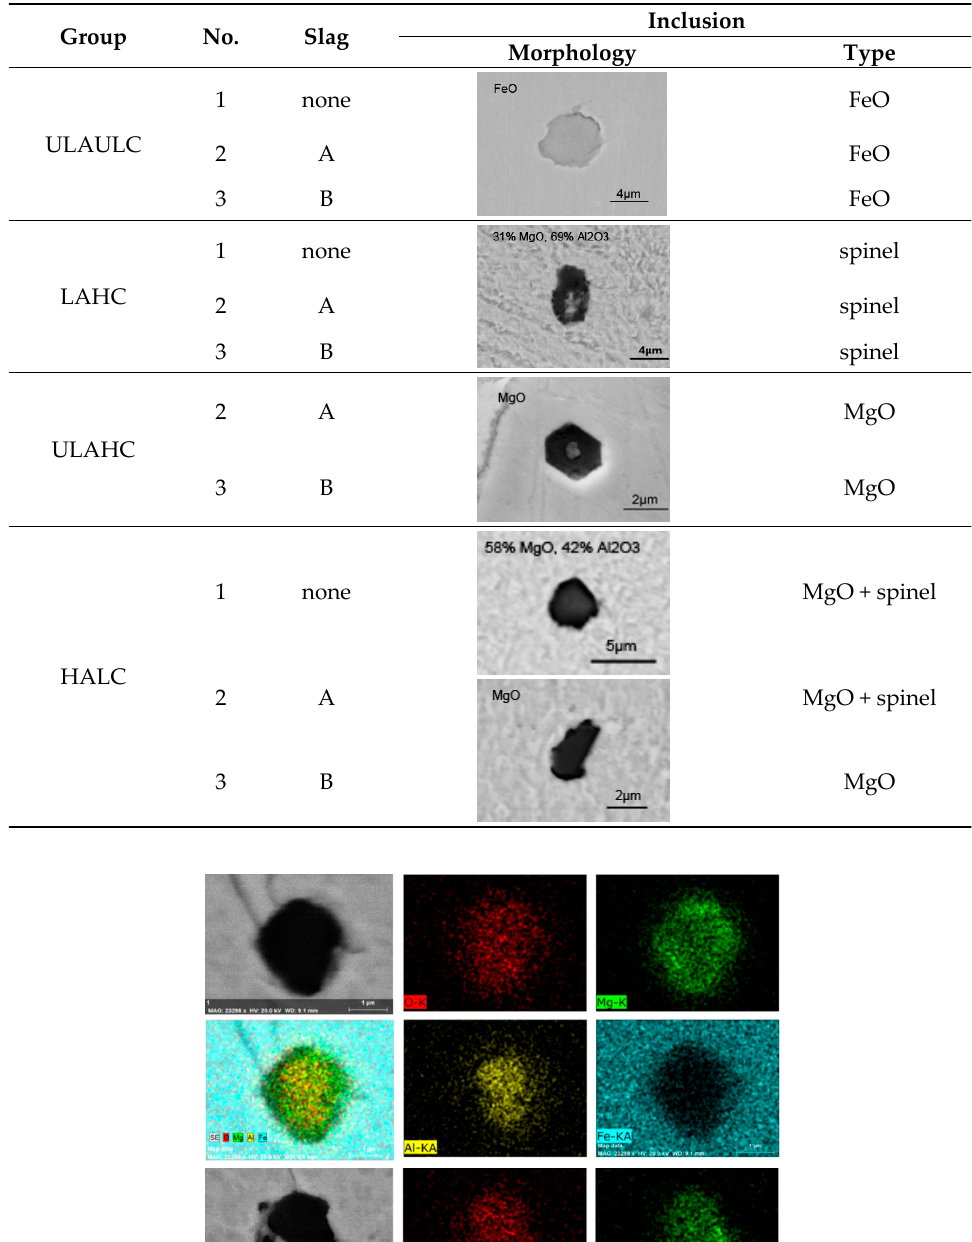
Table 5. Inclusion characteristics after quasi-equilibrium experiments.